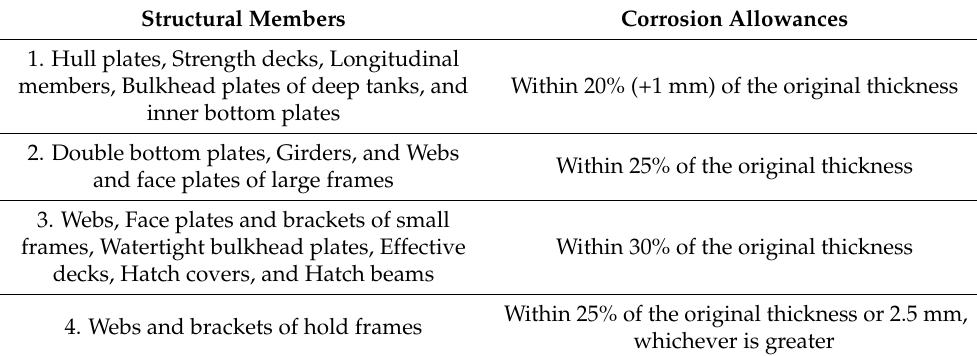
Table 5. A Guidance for corrosion allowances